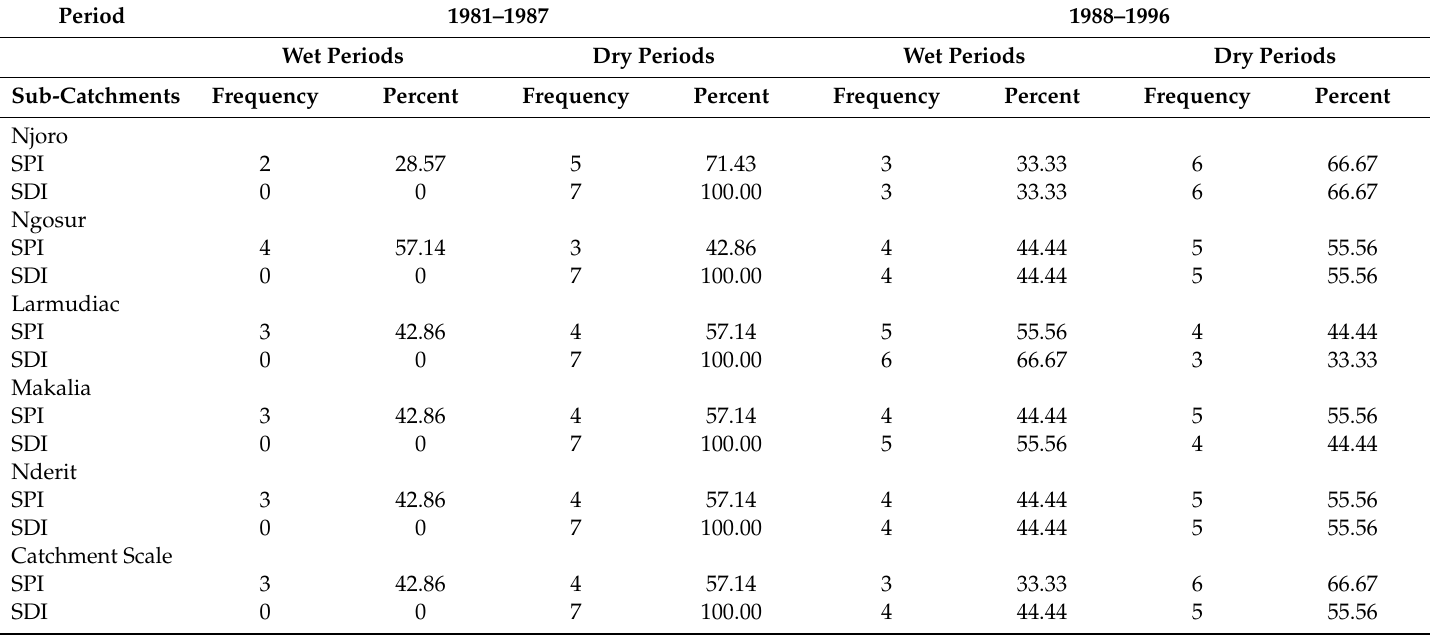
Table 8. Distribution of wet and dry periods for 12-month SDI and SPI for Lake Nakuru subcatchments and the entire